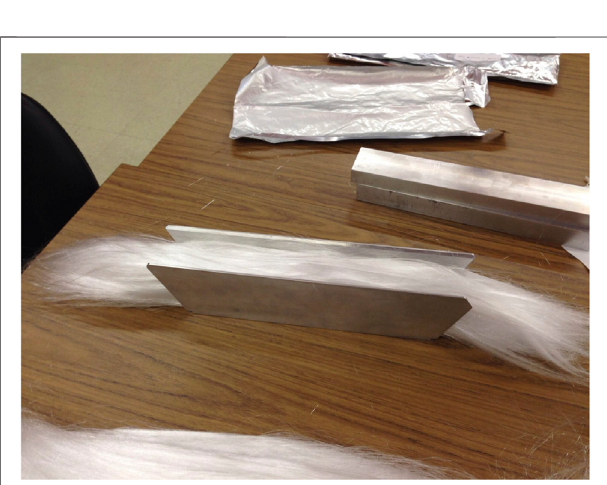
FIGURE 5 | The polyester and PMMA fi ber strands are randomly mixed and assembled into a holder to create the polymer TALOF preform.